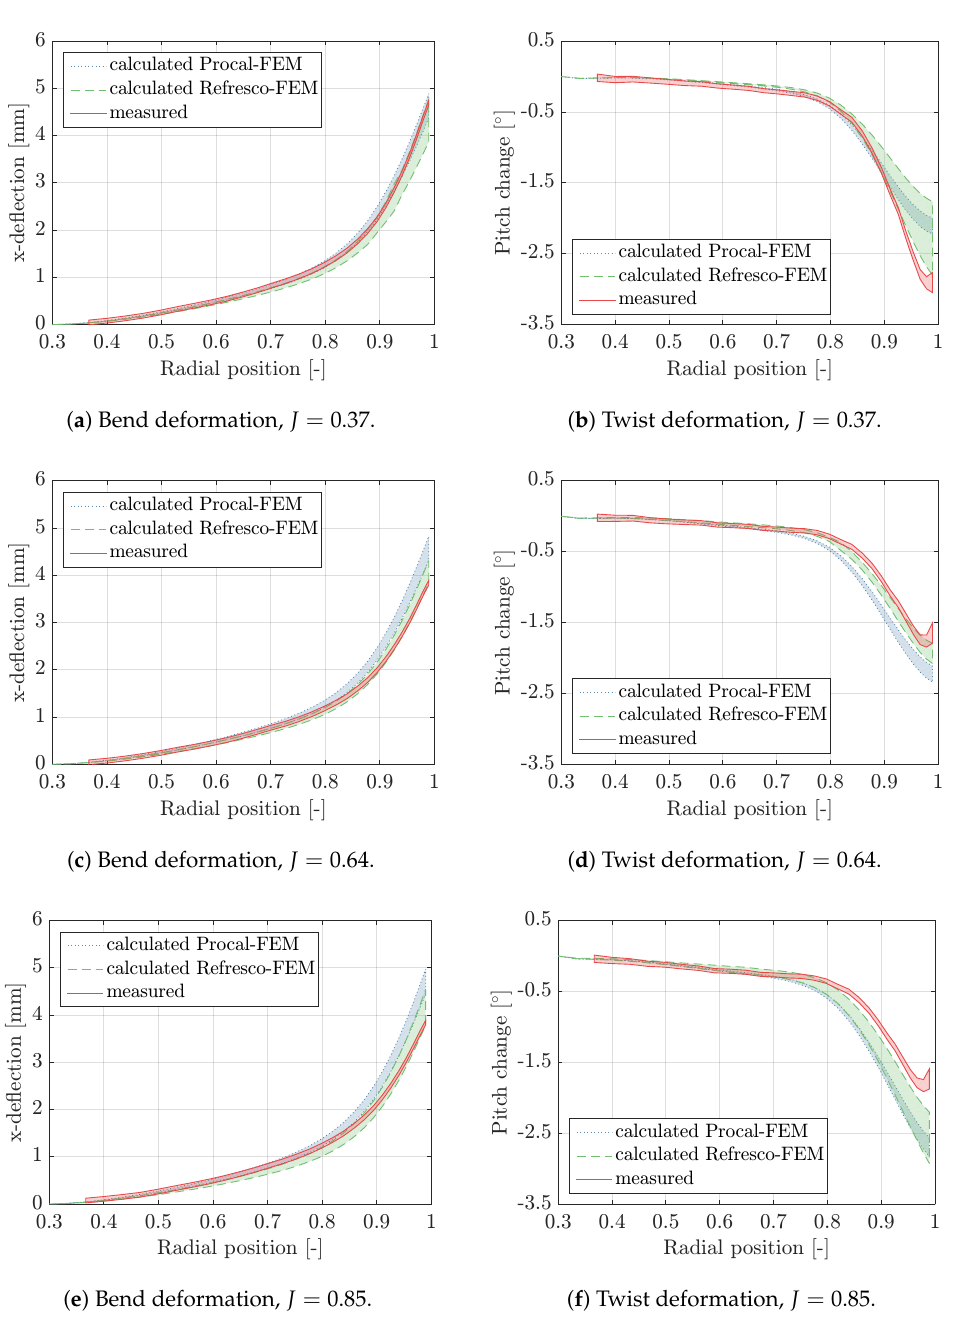
Figure 16. Uncertainty intervals for bend ( left ) and twist ( right ) deformations of mid-chord points of epoxy propeller blade 1 against the radial position on the blade, for the measured and calculated